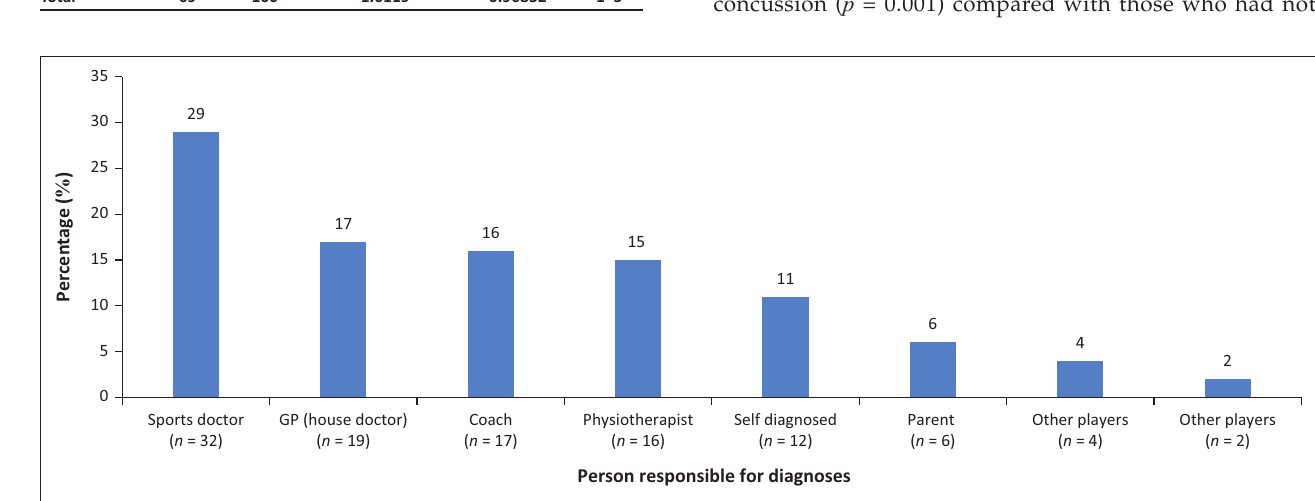
FIG URE 1: Person responsible for diagnosing